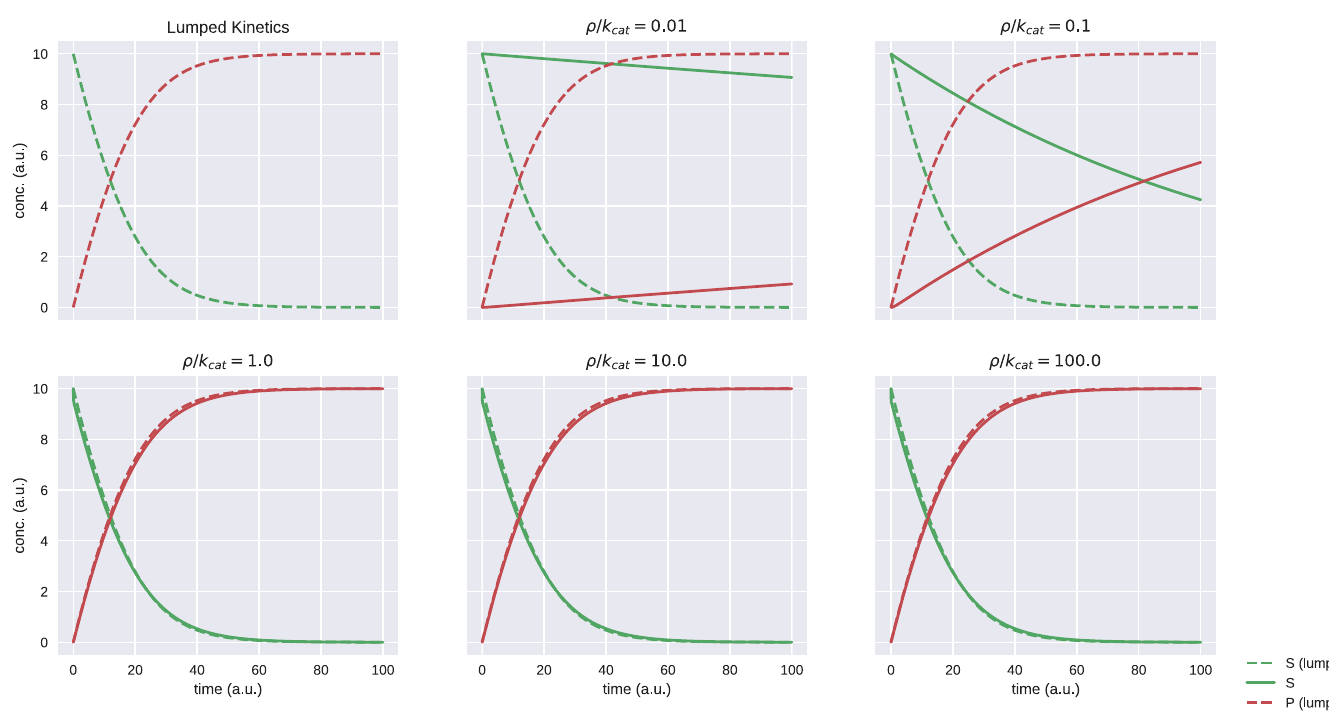
Fig 8. Different margin values and their respective simulations. In these simulations, E = 1, S initial = 10, k cat = 1, and K M = 10. For the elementary two–process network, the reverse binding rate is calculated automatically by the compiler using the supplied value of ρ as k